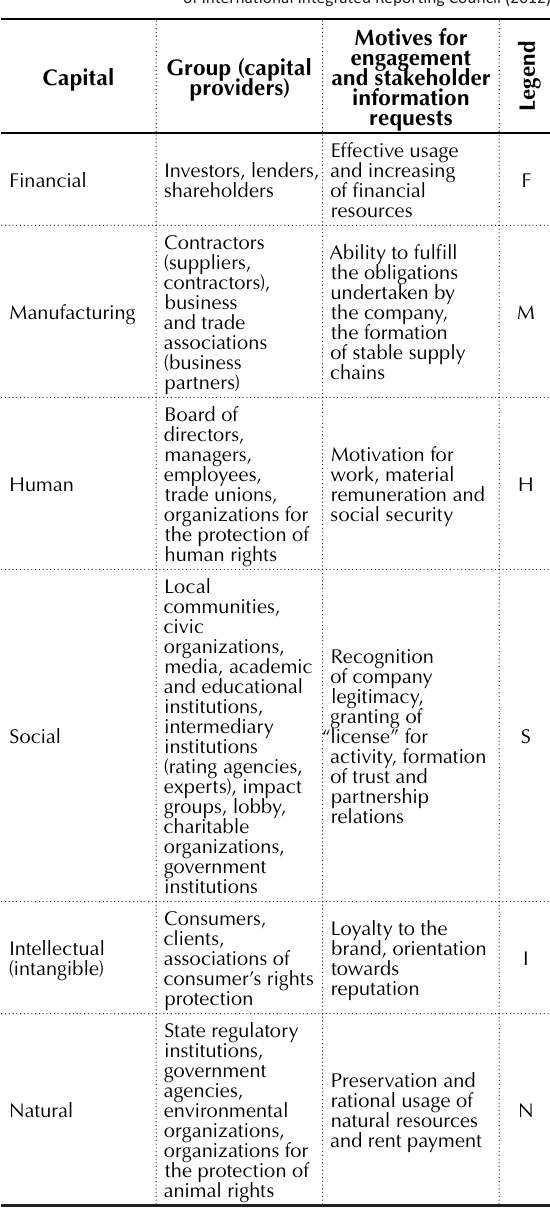
Table 1. Key stakeholder groups in accordance with the concept of capital and multi-stakeholder